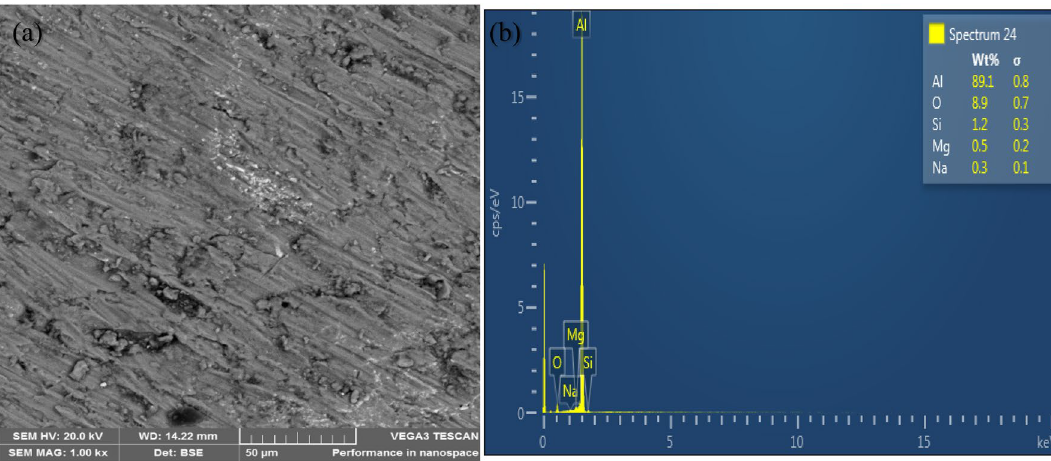
Figure 7. Representative morphology of reinforced composite (A5) ( a , b